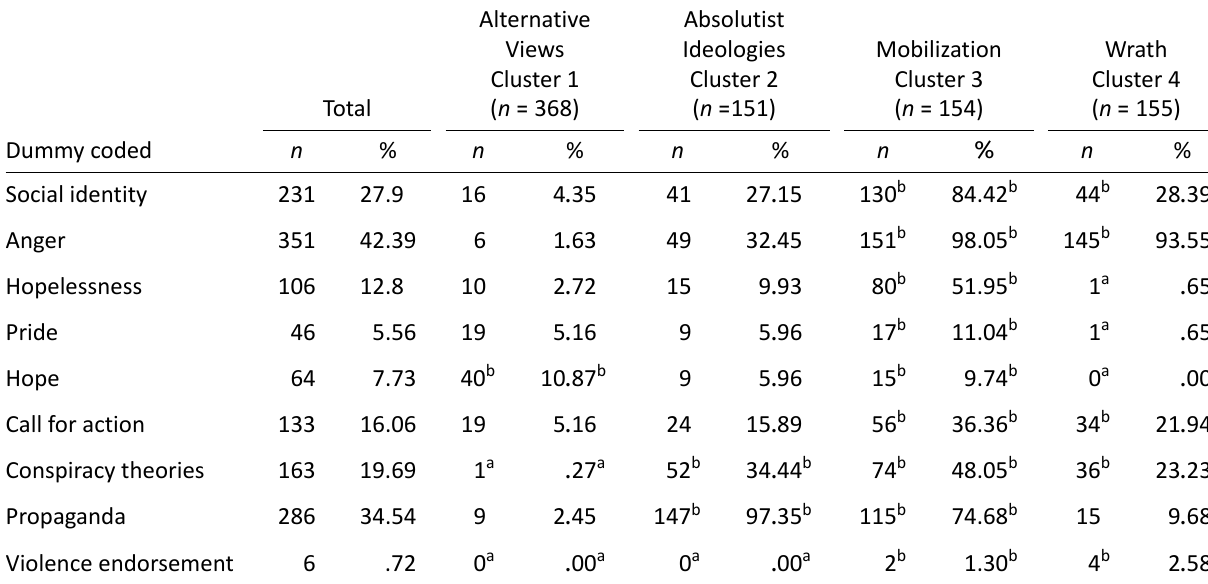
Table 4. Prevalence of categories per cluster.